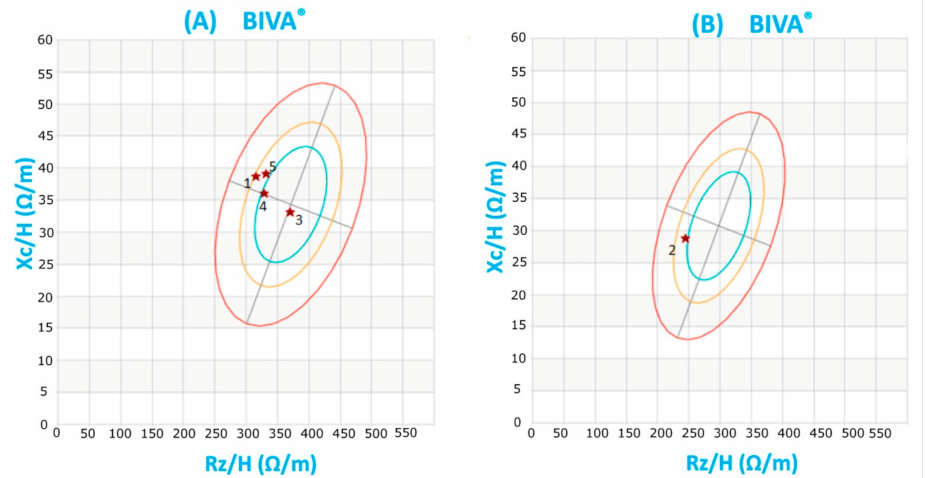
Figure 1. Subjects’ Bioelectrical Impedance Vector Analysis (BIVA): The graphical representation (R-Xcgraph) known as BiaVector ® represents resistance (Rz) and reactance (Xc) normalized by height. Rz and Xc were measured at 50 kHz. The three concentric ellipses, proceeding from the center towards the periphery of the graph, represent the 50th, 75th and 95th percentiles of the BIVA distribution in a reference population. Each subject was plotted in the R-Xcgraph. BIVA shows that all subjects fall within the 75th percentile ellipse for the reference population, ( A ) females and ( B ) males, demonstrating the absence of significant hydration and body composition abnormalities. Table 2. Compositions of the A (with blueberries) and B (without blueberries) Meals.